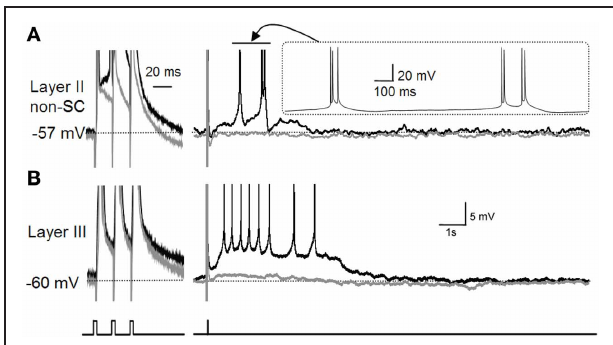
FIGURE 3 | Effect of M-current suppression on persistent firing. (A) The effect of the M-current in layer II non-stellate cells in the MEC. (B) The effect of the M-current in layer III pyramidal cells in the MEC. Suppression of the M-current by linopirdine revealed a plateau potential after three induced spikes in both types of neurons with different firing properties. Layer II non-stellate cells fired in a high-frequency burst while layer III cells fired regularly during plateau potential. Gray traces are control recordings and black traces are recordings in linopirdine. non-SC, non-stellate cell. Figures were modified from Yoshida and Alonso